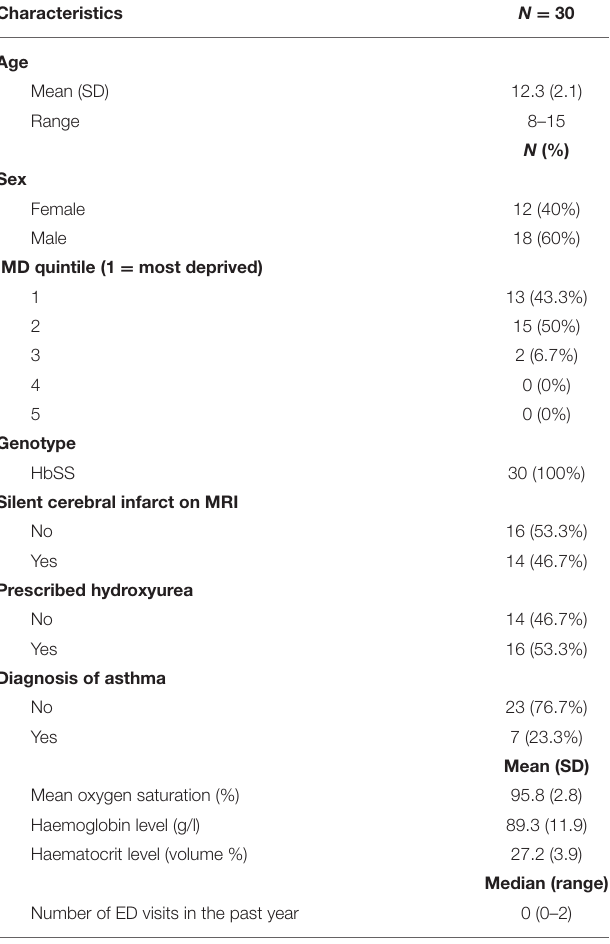
TABLE 1 | Characteristics of POMS2b paediatric patients at baseline before randomisation. Characteristics